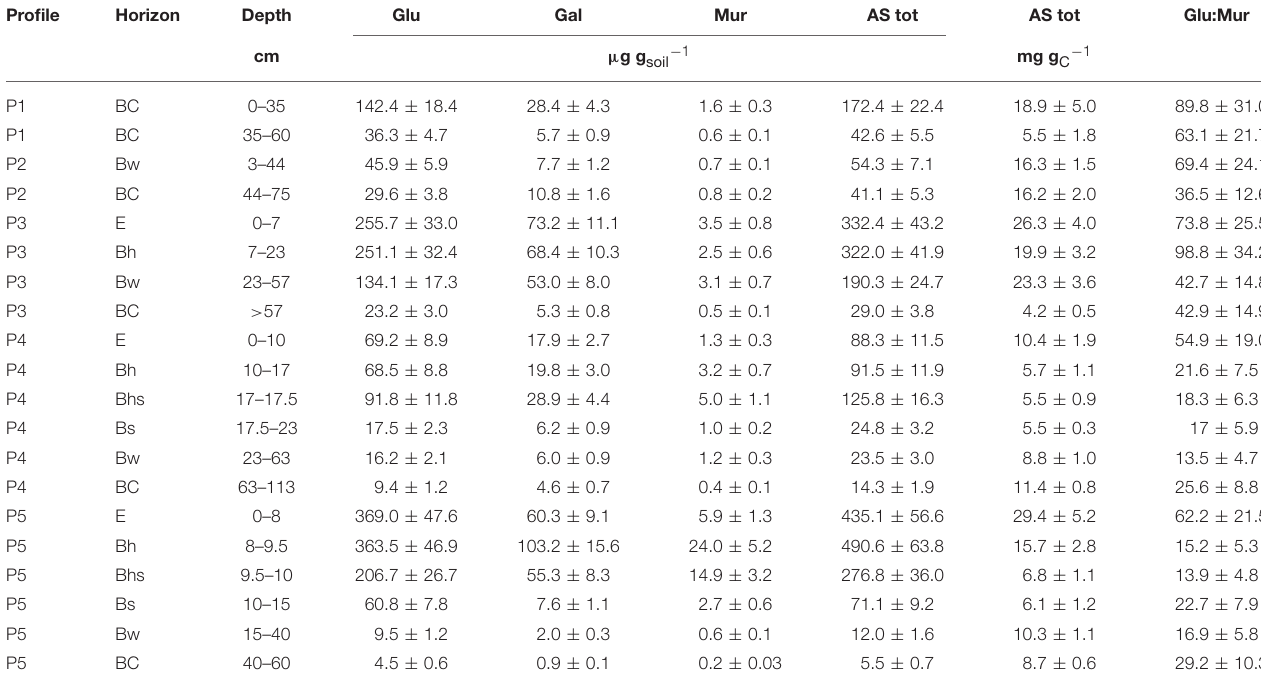
TABLE 3 | Amino-sugars: Glucosamine (Glu), Galactosamine (Gal), Muramic acids (Mur) content, in µ gAS g − 1 soil , total Amino-sugar content ( µ g AS g − 1 soil and mg AS g − 1 C ) and Glu:Mur ratio (values are given ± one standard deviation).